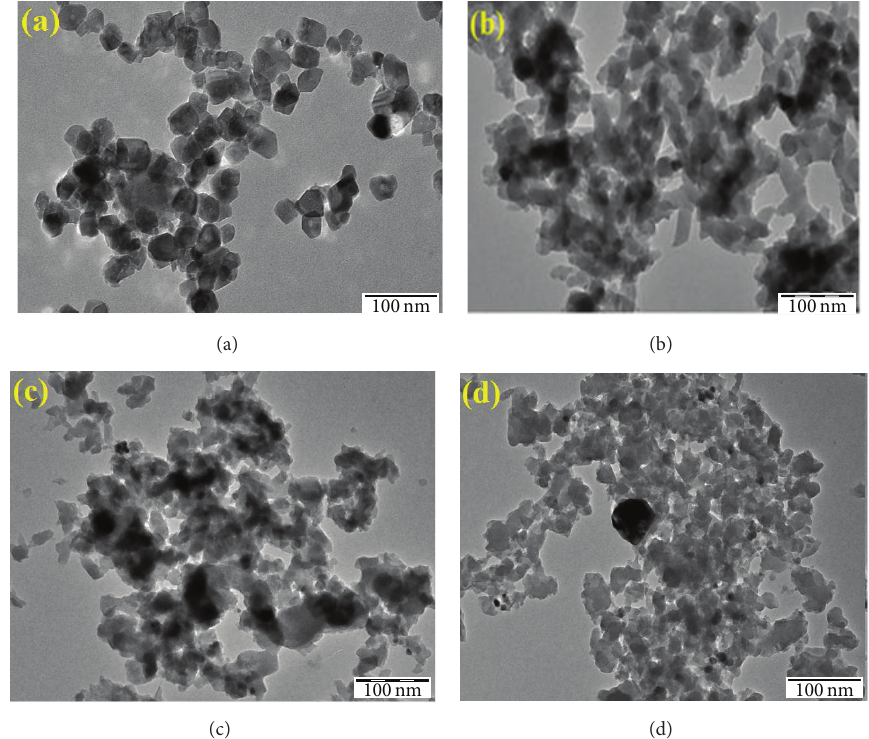
Figure 3: TEM photographs of (a) TiO 2 particles, (b) TiO 2 /PANi, (c) TiO 2 /C, and (d) TiO 2 /AC, respectively (magnification 45000x).